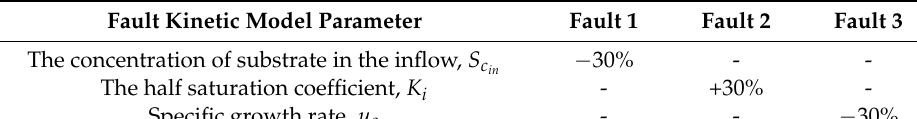
Table 2. Faulty scenario for the wastewater treatment system.